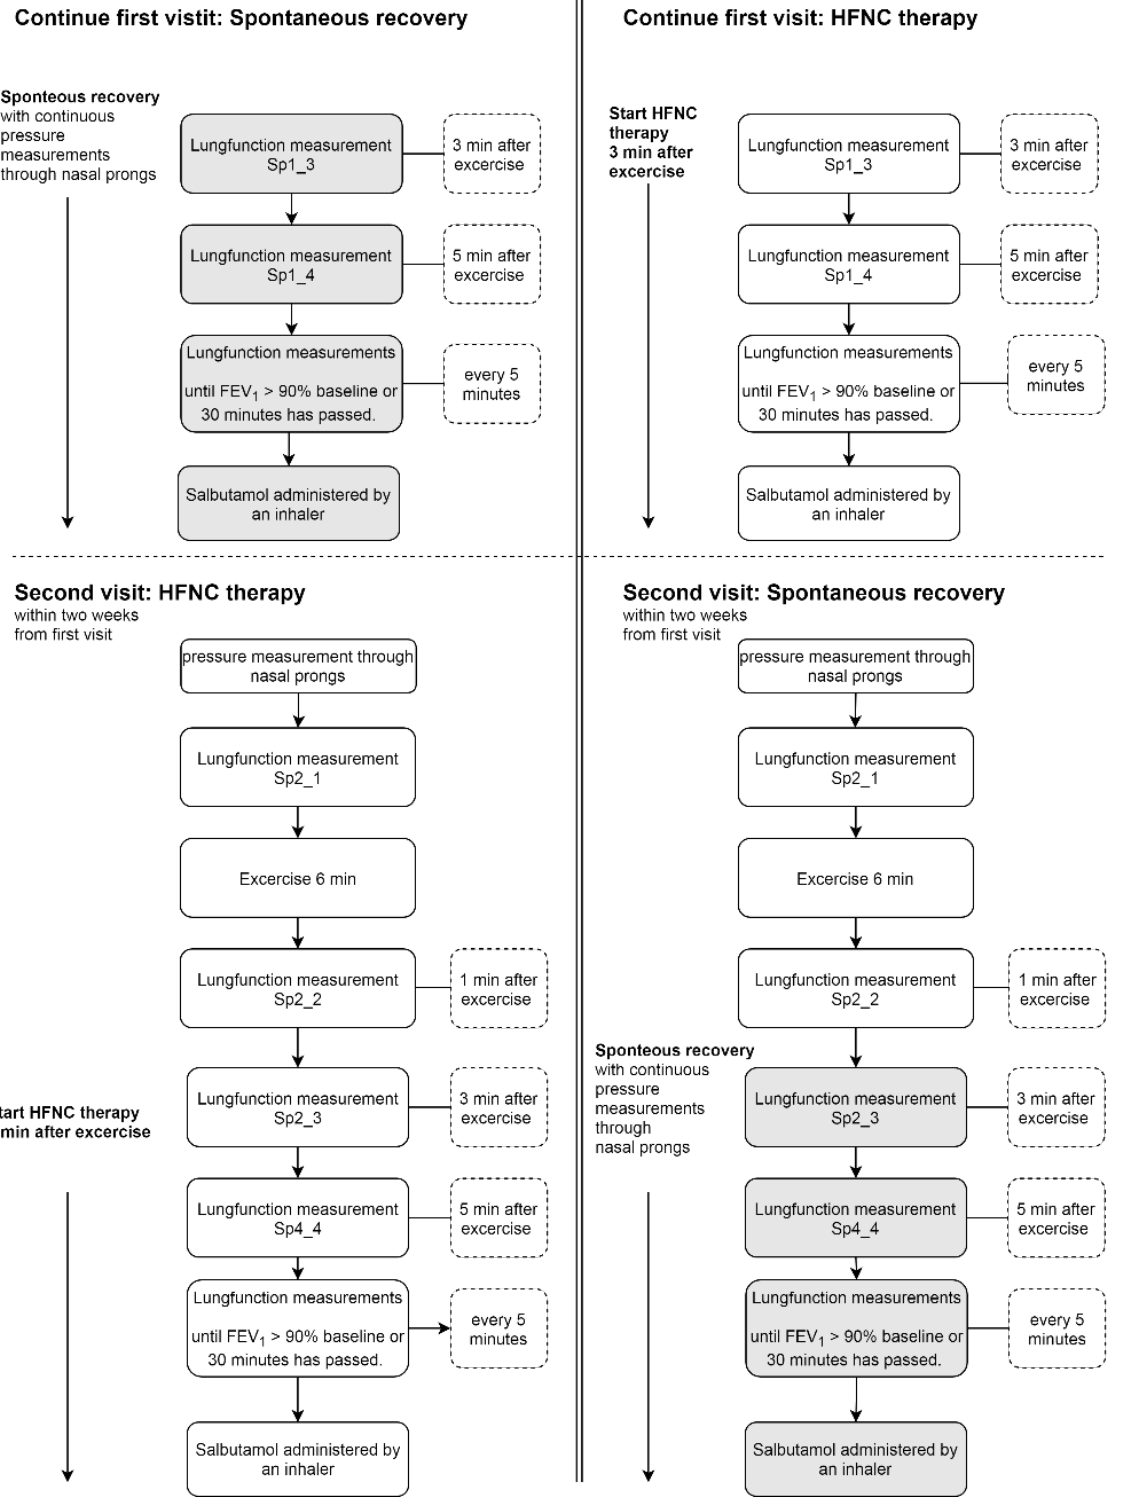
Figure 4. Study design (part 2 of 2).